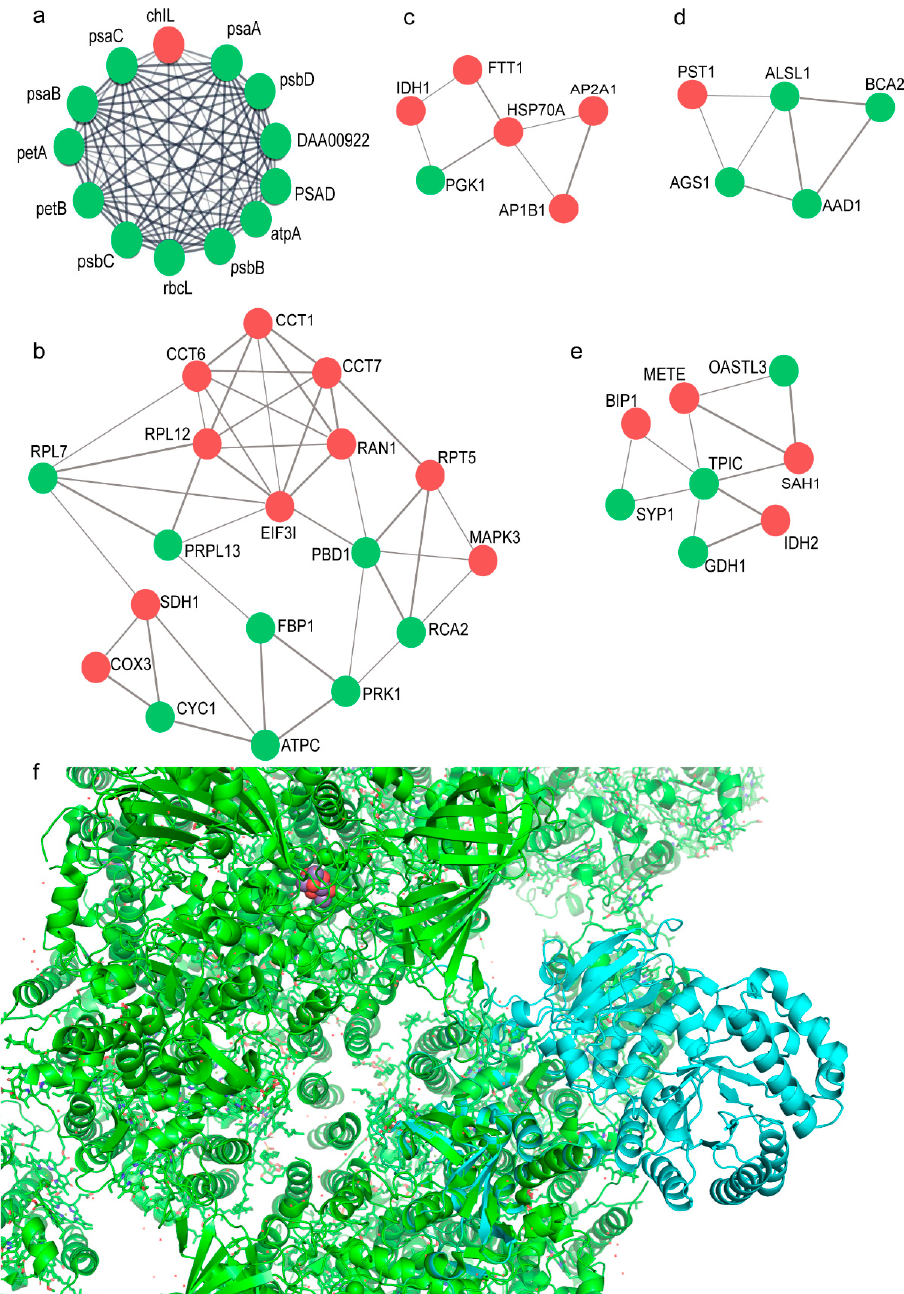
Figure 6. MCODE analysis of the protein–protein interaction network of Chromochloris zofingiensis with or without glucose: ( a ) Cluster 1; ( b ) Cluster 2; ( c ) Cluster 3; ( d ) Cluster 4; ( e ) Cluster 5. The node in red color means an upregulated protein; the node in green color represents a downregulated protein. The width of line indicates the interaction strength of the proteins. ( f ) Molecular docking analysis result for psbB (receptor) and rbcL (ligand) by ZDOCK; the receptor is in green and the interaction complex in cyan.